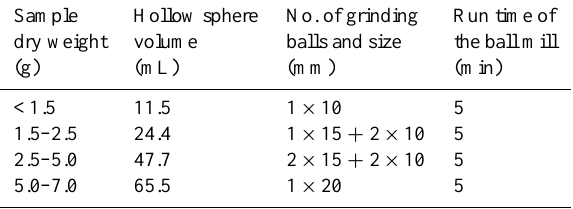
Table 1. Depending on the dry weight of the freeze-dried sedi- ment trap samples, different grinding sphere volumes and numbers of grinding balls (10–20mm) are recommended to achieve optimal grinding results at a set run time of the ball mill (5min). The optimal combination of the different factors was determined empirically to achieve a grain size smaller than 63µm and to minimize frictional heating of the samples.